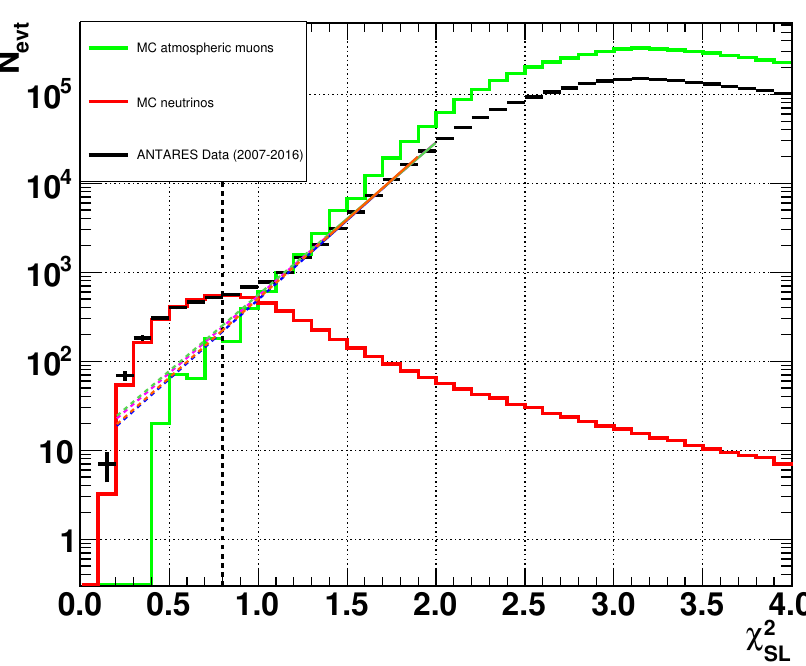
Figure 3 . Distribution of reduced (cid:31) 2 values for events which have been reconstructed by method A SL (SL). Data (black crosses) with error bars indicating the statistical uncertainty are shown together with MC neutrino events (red line) and MC atmospheric muons (green line). The dashed black line at (cid:31) 2 = 0 : 8 indicates the value of the applied cut on this parameter. The (cid:12)tted functions used to SL estimate the background of atmospheric muons are shown as well (solid coloured lines), together with their extrapolation into the signal region left to the cut value (dashed coloured lines, see text for